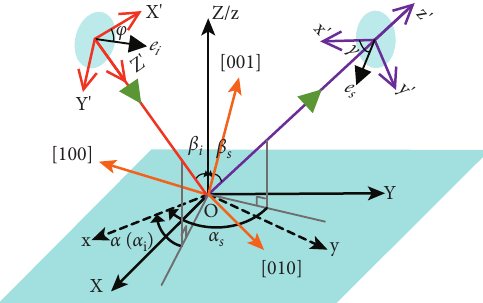
Figure 1: Definitions of coordinate systems and angle parameters. The green triangle represents the direction of light propagation; the red line and purple line represent the incident laser and scattering light, respectively. Five coordinate systems are shown in this figure, the incident laser coordinate system ( X ′ Y ′ Z ′ ), the scattered light coordinate system ( x ′ y ′ z ′ ), the space coordinate system ( XYZ ), the sample coordinate system ( xyz ), and the crystal coordinate system ([100] [010] [001]),